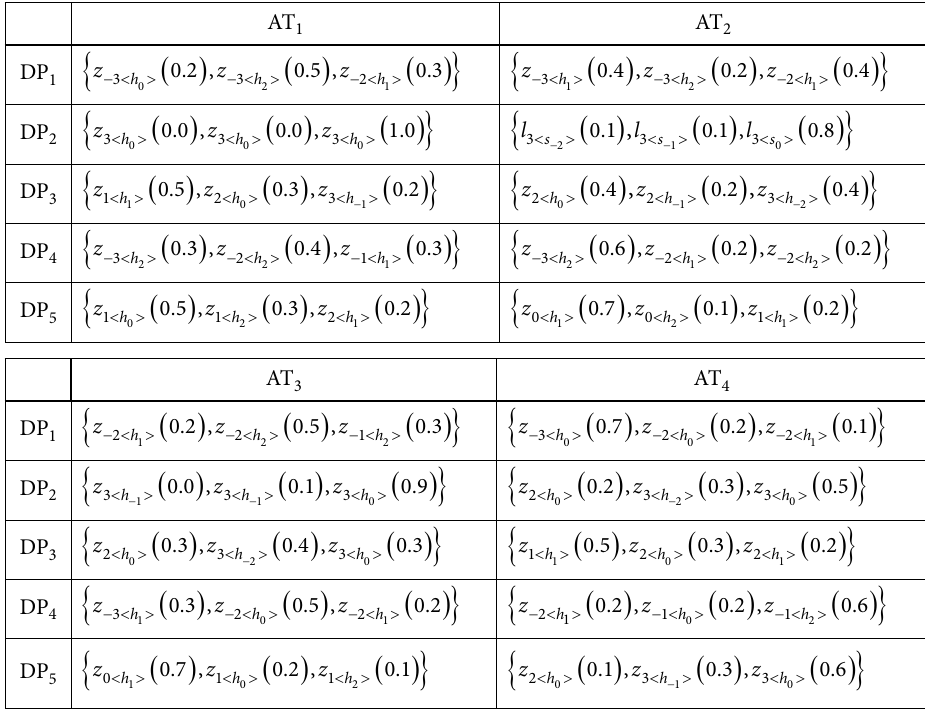
Table 5. The normalized PDHLTSs evaluation of each alternative is provided by e 2 AT 1 AT 2 DP 1